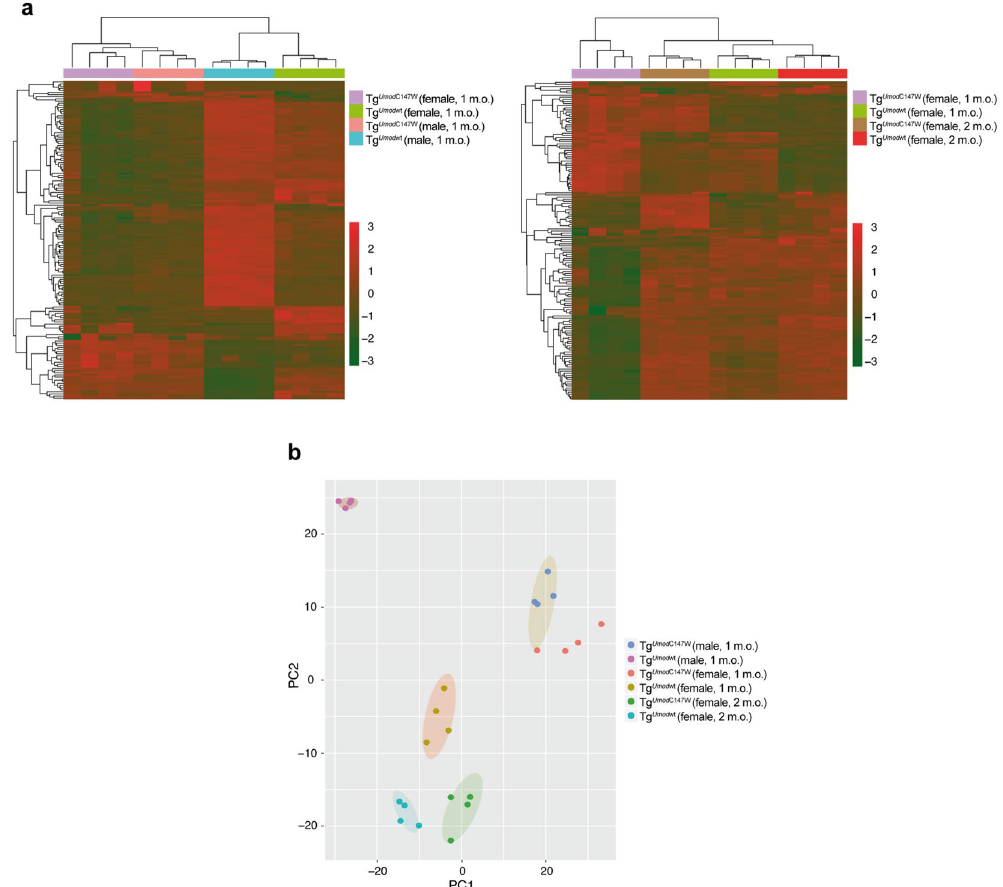
Figure 2. Multivariate Analysis and Principal Component Analysis (PCA) of experimental samples and groups. ( a ) The figure shows hierarchical clustering on the 150 genes showing the greatest inter-group variance among expressed genes in mice at 1 month of age (left panel) or in female mice only (right panel). ( b ) PCA based on the expression values of the 17,200 genes detected in the experimental samples (detection P value < 0.01 in at least one sample of an analysed series). A bi-dimensional visualization of the first two principal components is shown (PC1 accounted for 35.2% and PC2 for 25% of the variance among samples).